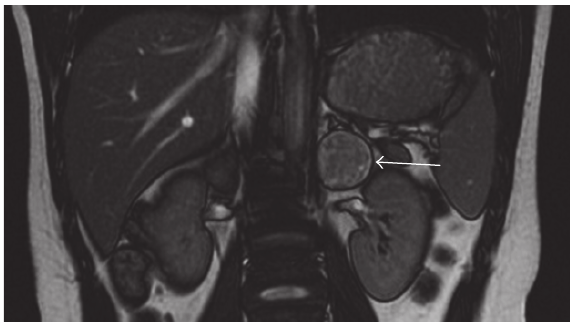
Figure 4: The tumor’s microscopic sections: the fibrous capsule (C) and Antoni A areas where the cells showed a Palisade sequence (A) and hypocellular/loose Antoni B areas (B) (Hematoxylin and Eosin, ×